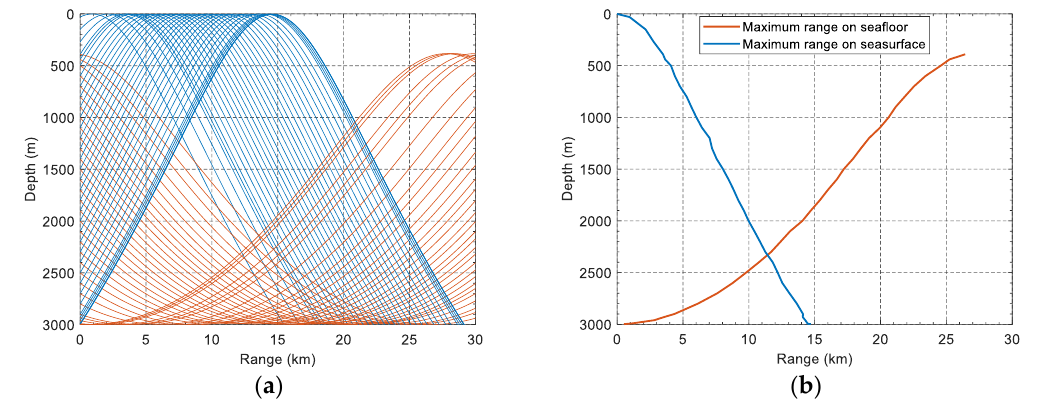
Figure 7. Simulation of acoustic ray bending. ( a ) Acoustic propagation path of the base station at different depths, with the rays grazing the sea surface or the seafloor. Blue and orange colors denote the rays grazing the sea surface and the seafloor, respectively; ( b ) base station maximum service range on the sea surface and the seafloor. Blue and orange colors denote the rays grazing the sea surface and the seafloor, respectively.